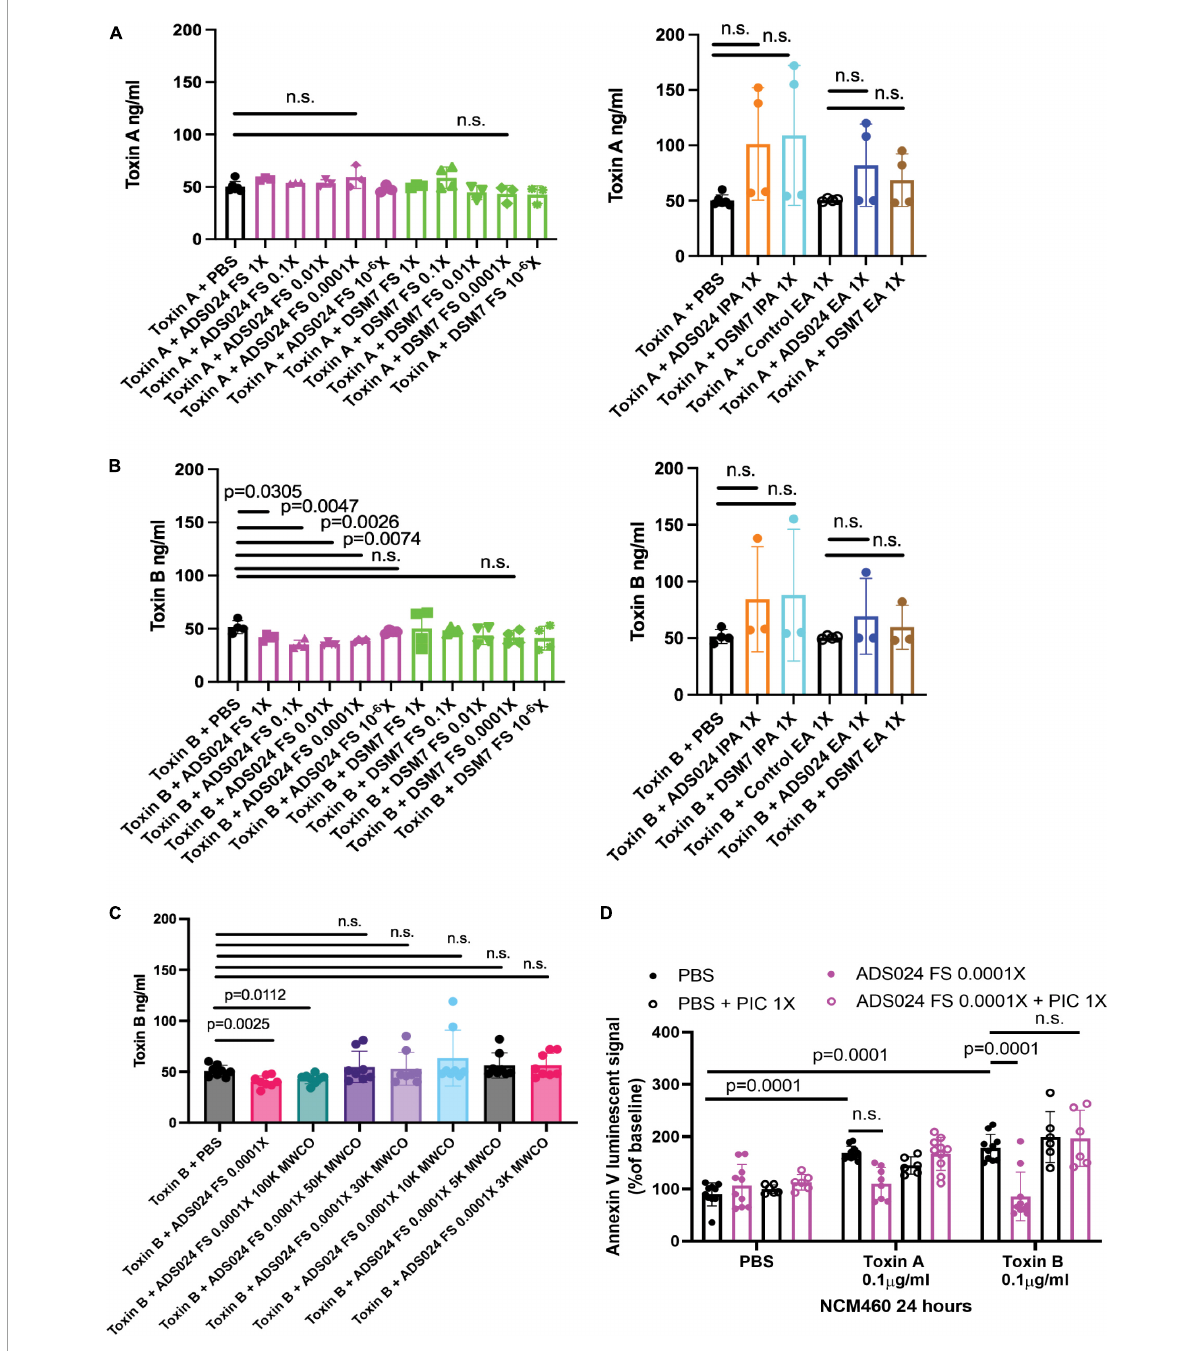
FIGURE5 Protease inhibitors abolished the anti-apoptotic effect of ADS024 sterile filtrate. (A–C) Toxin digestion assays. Sterile filtrates, IPA extracts, and EA extracts of ADS024 and DSM7 from 1X to 10 - 6 X were added to serum-free RPMI1640 containing 50 ng/500 µ l toxin A or toxin B. (C) ADS024 filtrates were further processed by MWCO columns. The centrifuged eluates were diluted to 0.0001X and added to serum-free RPMI1640 containing 50 ng/500 µ l toxin B. (A–C) The mixtures were incubated at 37 ◦ C for 1 h and then stopped by adding a PIC and EDTA mixture (#PI78429, Thermo Scientific) in 1:100 dilution ratio. The toxin levels in the mixtures were measured by ELISA. ADS024 FS at 1–0.0001X partially degraded toxin B. MWCO at 50kDa abolished this effect. (D) Apoptosis assay. Serum-starved NCM460 cells were pretreated with ADS024 sterile filtrate at 0.0001X with or without protease inhibitor cocktail at 1X. Reagents of Promega RealTime-Glo Annexin V apoptosis assay in a 1:1,000 ratio were added simultaneously. Thirty minutes later, toxin A or toxin B (0.1 µ g/ml) was added to start the apoptosis process. After 24 h, the luminescent (apoptosis) signals were read by a 96-plate reader. The Annexin V luminescent signal above 100% indicated the occurrence of apoptosis. The ADS024 sterile filtrate-mediated inhibition of apoptosis in toxin B-treated cells was reversed by pretreatment of PIC at 1X. Results were pooled from 3–4 independent experiments. One-way ANOVA tests were